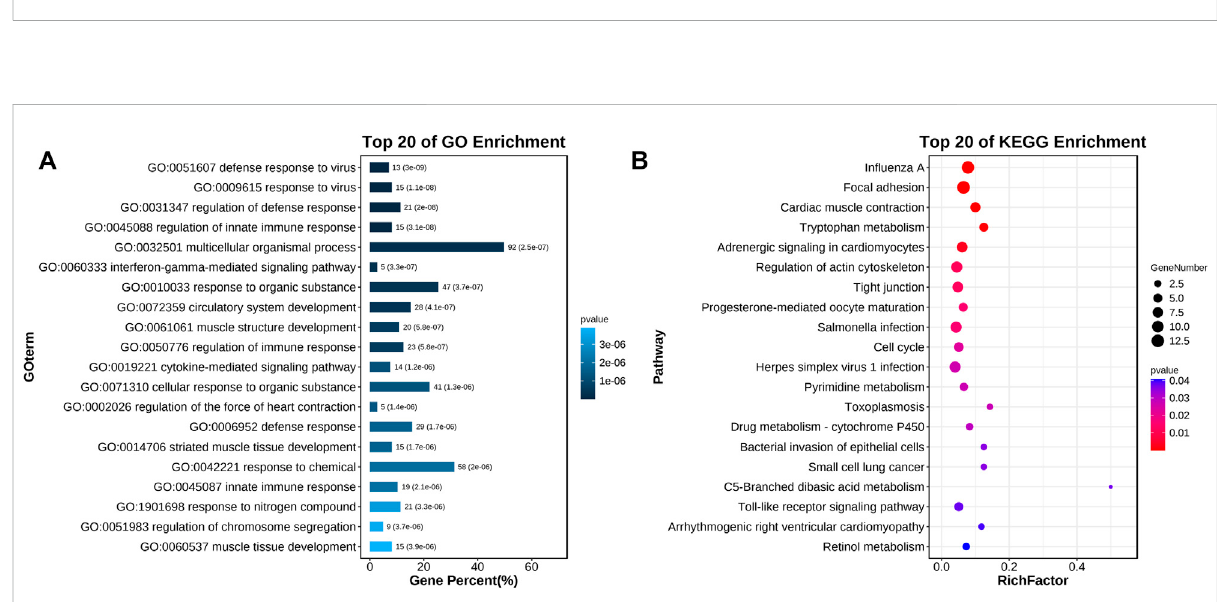
FIGURE 2 The relative expression levels of miR-499-5p, MYH7B , MYH1B , and MYH1E in miR-499-5p overexpressing CPMs and negative control by qRT- PCR. All results are shown as mean ± SD. ** p < 0.01 as compared with the control.